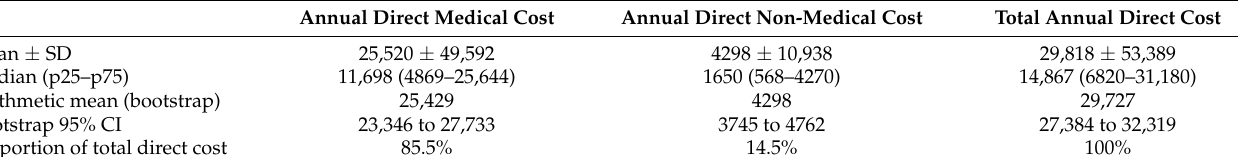
Table 2. Annual direct cost of SLE per patient (Unit: CNY).